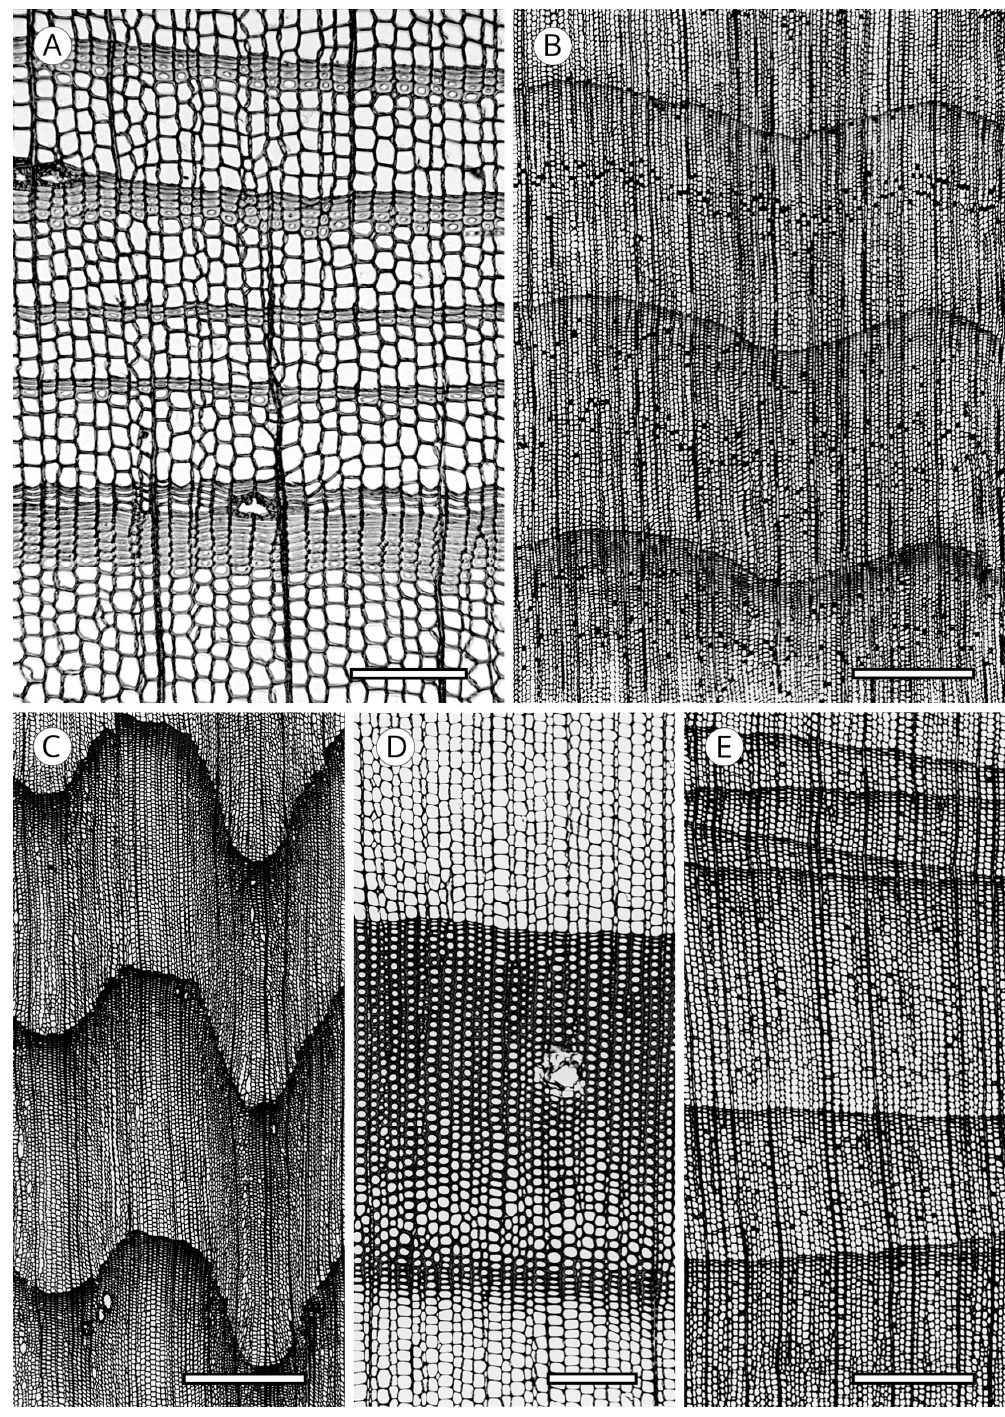
Figure 8. Growth rings. ( A ) Normal rings in Larix sibirica Ledeb.; ( B ) Undulating rings in Pilgerodendron uviferum (D.Don) Florin; ( C ) Hazel growth rings in Picea abies (L.) H.Karst.; ( D ) False growth ring in Pinus sylvestris L.; ( E ) Wedging rings in Nageia nagi (Thunb.) Kuntze. Scale bars. ( A ) = 50 µ m; ( B , C , E ) = 1 mm; ( D ) = 250 μ m.